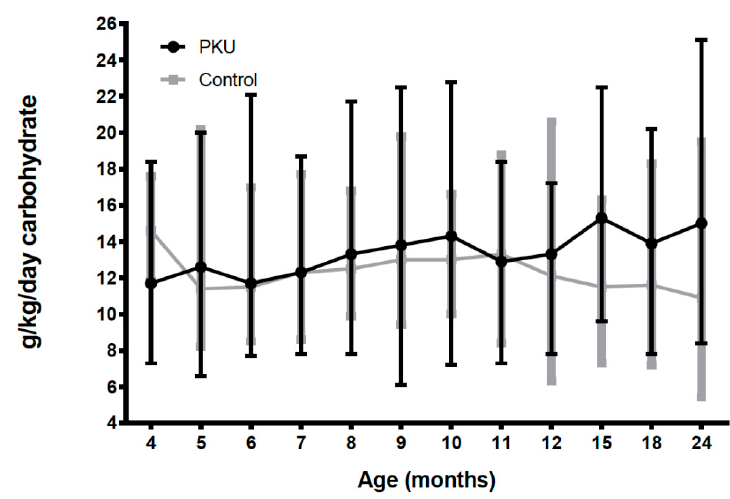
Figure 6. Mean carbohydrate intake (g/kg/day) for PKU and control groups by age. 3.6. Energy Intake from Protein Substitutes (PKU Group Only) (Excludes Energy Contribution from Food)